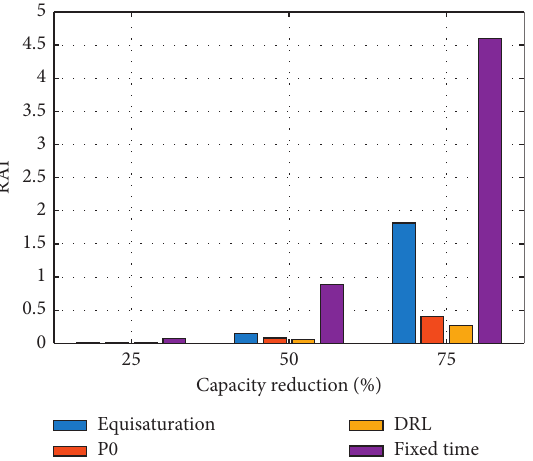
Figure 8: Comparisons of resilience for the small network under different levels of disruptions with different signal